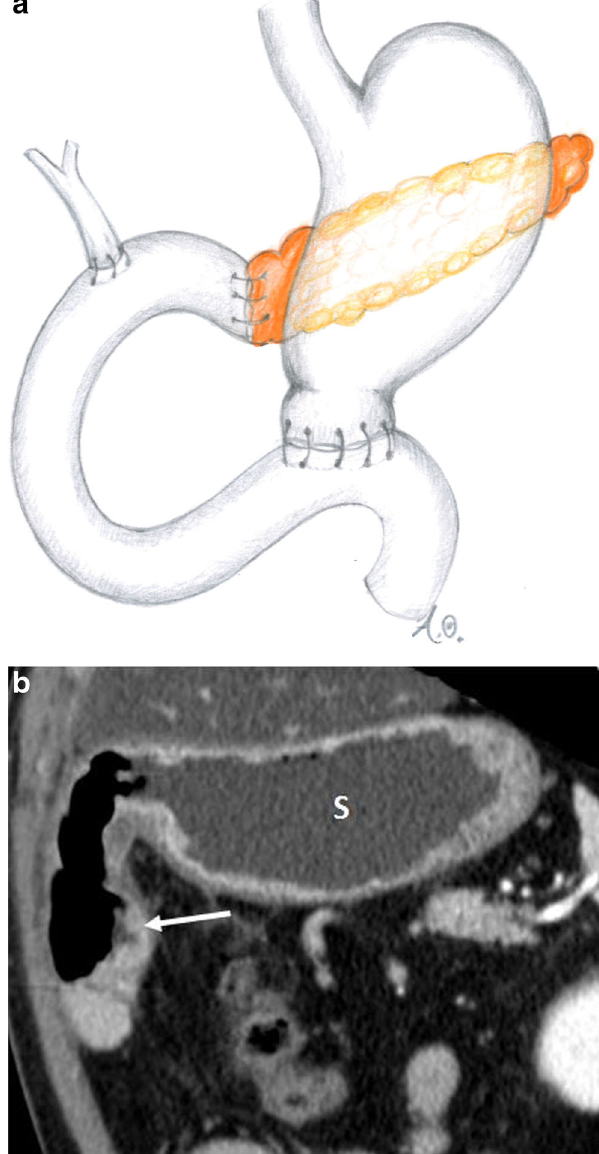
Fig. 1 Whipple procedure ( a , b ). a Drawing. b Coronal CT image. The stomach (s) and the gastrojejunostomy (white arrow) after the Whipple procedure are